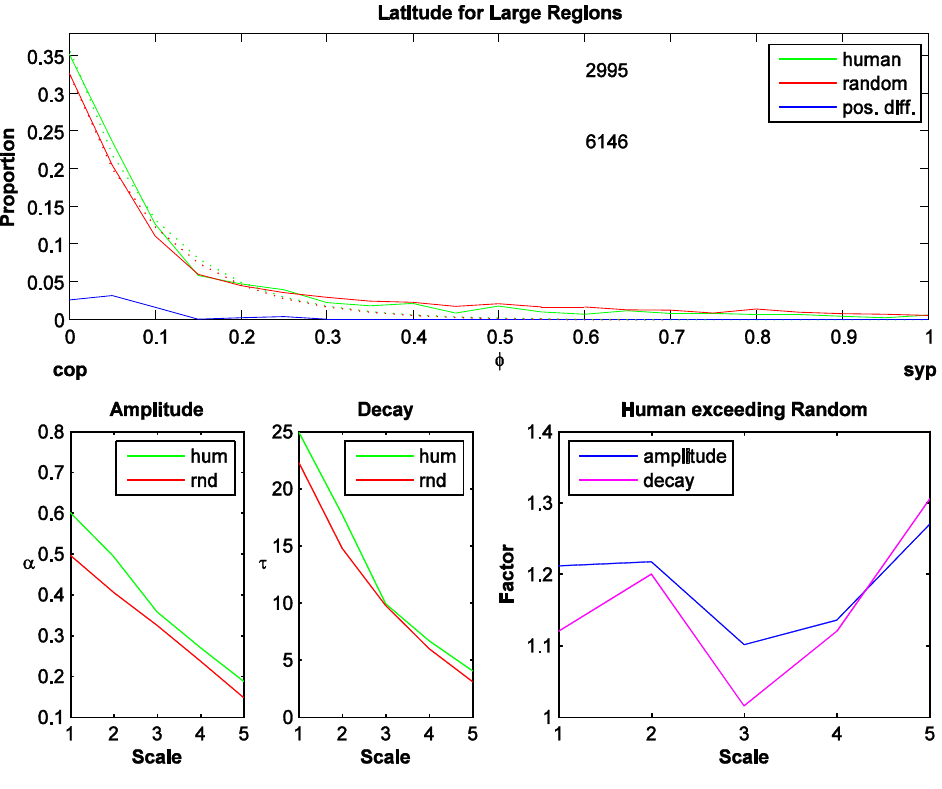
Figure 3. Latitude for large regions (sym-axes with high DM value). Top plot: Latitude histogram for scale 3. X-axis: Latitude: ranges from contour pixel (cop; value=0) to sym-point (syp; value=1). Green: human fixations; red: random fixations; blue: preference distribution: positive difference of actual (human) distribution minus random distribution. The two numbers denote the number of human and random fixations for each selection (upper and lower respectively). The dotted curves are exponential fits (αe (- τφ) ). Lower left two plots: amplitude (α) and decay rate (τ) of the fits for the 5 different scales (I 1 ,…, I 5 ). Lower right plot: Factor by which the actual distribution exceeds the random distribution (α hum /α rnd and τ hum / τ rnd